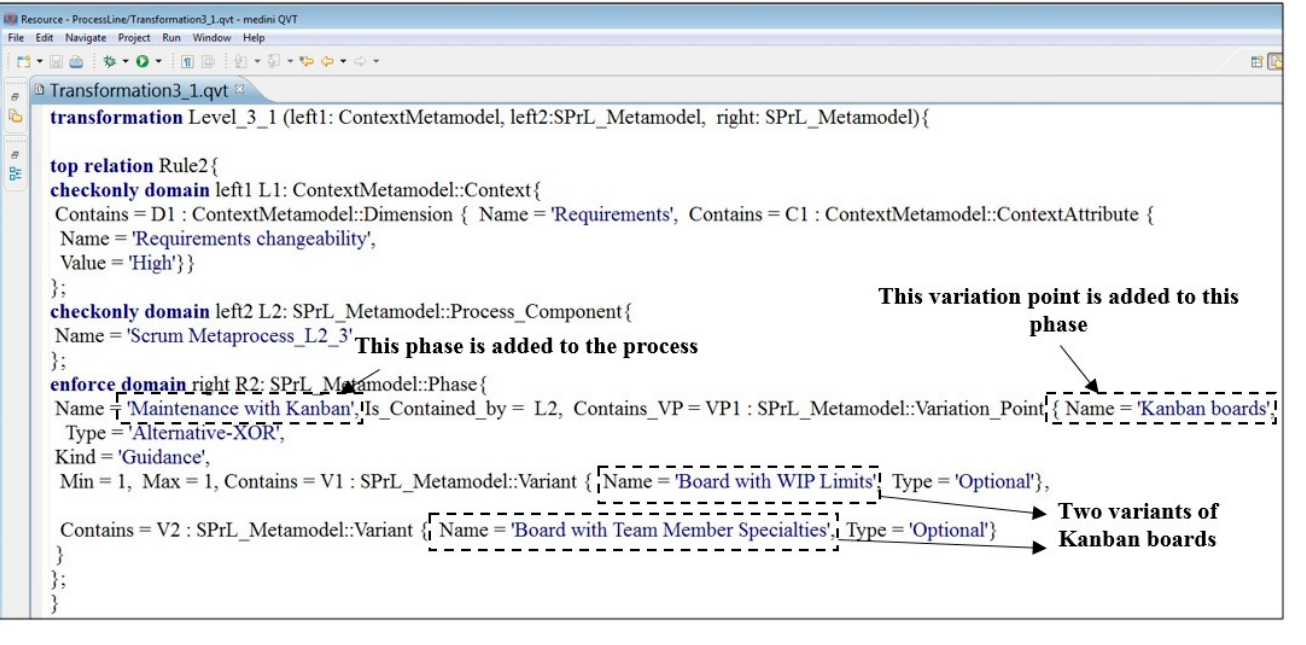
Figure A9. Transformation implemented for resolving the variability related to “Maintenance with Kanban”.